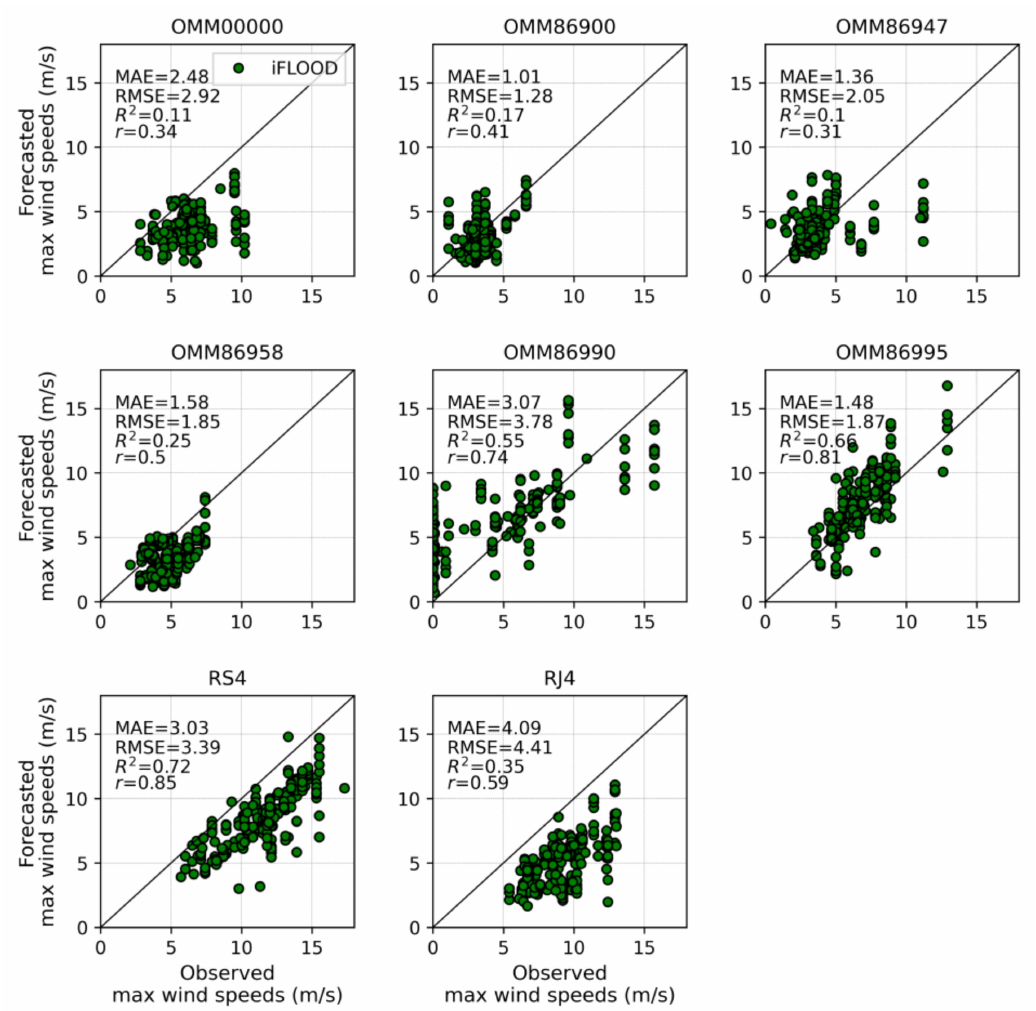
Figure4. Scatterplotsofpredictedmaximumwindmagnitudesvs. observedpeakspeedsat6meteorological stations and 2 wave recording stations under daily weather conditions from 26 April to 31 August 2020. The mean absolute error (MAE), root mean square error (RMSE), R-square coefficient (R2), and Pearson correlation coefficient (r) metrics are shown in each